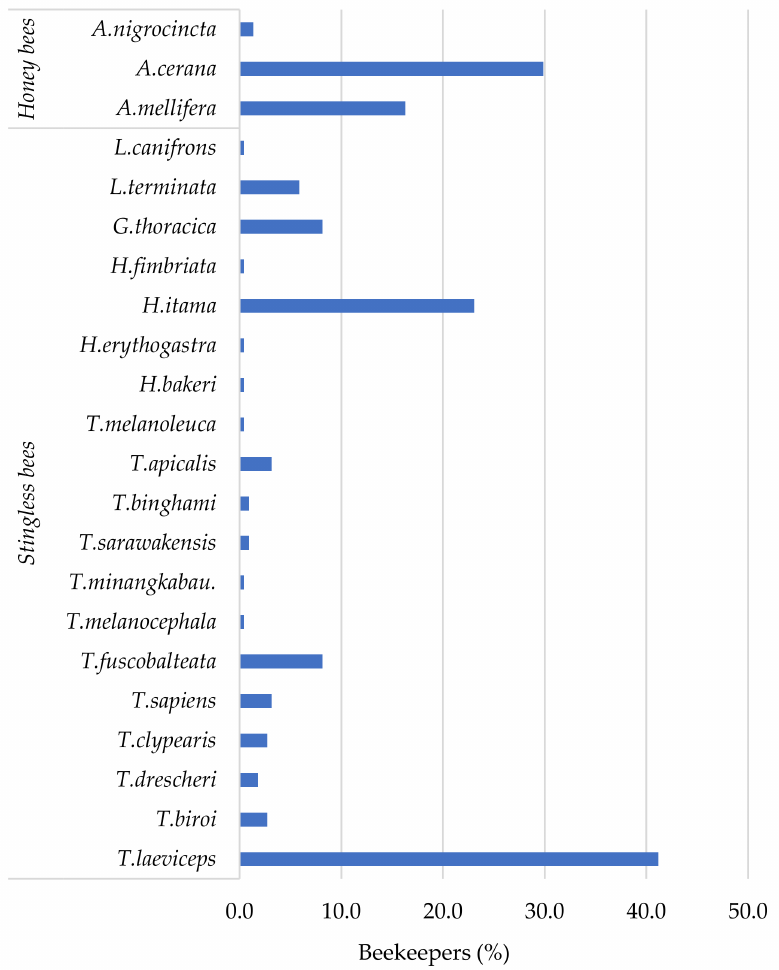
Figure 5. The preferences of beekeepers for selecting the species of honey bees and stingless bees ( n = 221).